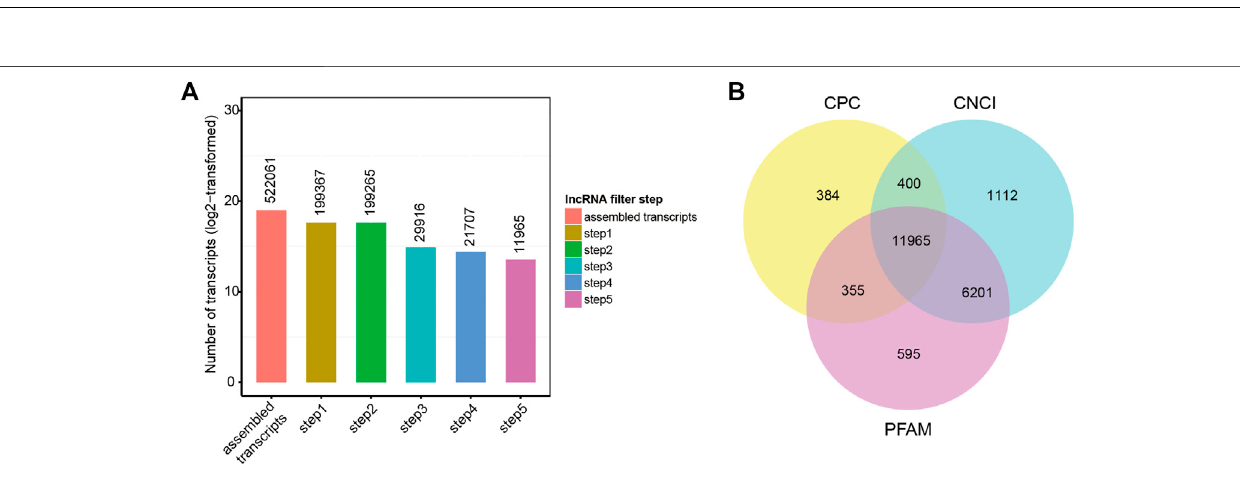
FIGURE2| Hormonalpro fi lingoftheresponsetothedifferentphotoperiodictreatments. (A) Meanfollicle-stimulatinghormone(FSH)levelsinbloodserumofewes sampled twice weekly throughout the experiment. (B) Mean of FSH for the SP and LP (12 time points each treatment). (C,D) Prolactin (PRL) pro fi les, the picture interpretation identical to those for FSH. Results were expressed as mean ± SE, * represents p < 0.05, ** represents p < 0.01, *** represents p < 0.001.